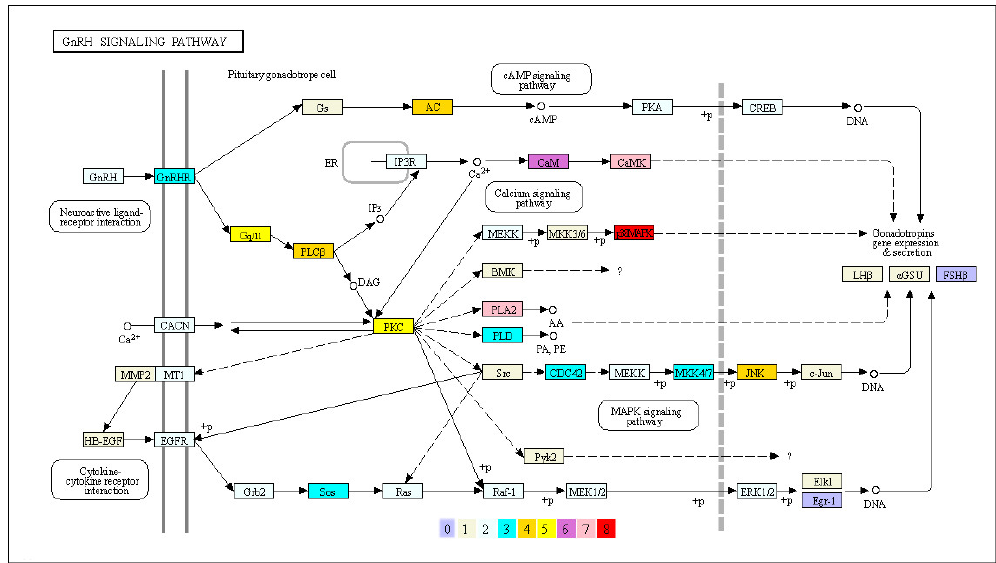
Figure 4. GnRH signaling pathway of male O. bidens ’ genome. The gene-marked colors indicate the gene copy number presented on this signaling pathway (KEGG ID: ko04912).